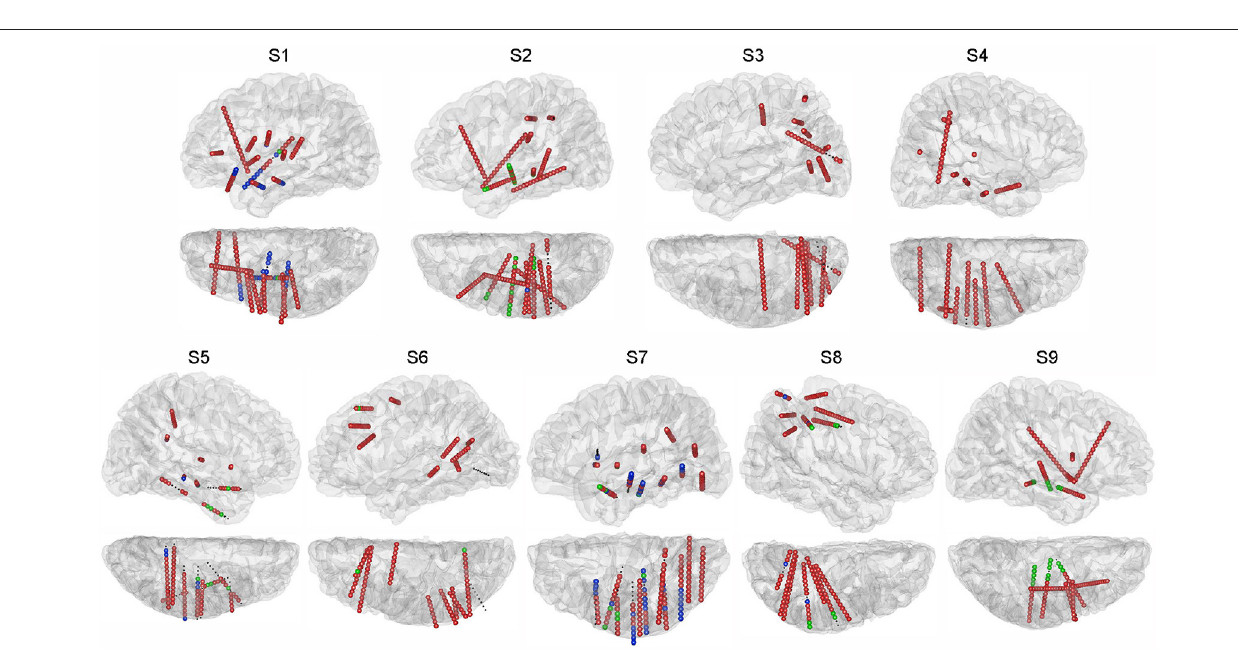
FIGURE 2 | Electrode locations projected on the individual brain. For each subject, sagittal and transverse views of the hemisphere with electrodes are shown. Subjects S1, S3, S6, and S9 have electrodes in both hemispheres, and only the hemispheres containing the majority of electrodes are shown. Different colors of the SEEG contacts indicate the session in which the contact was utilized: green for the auditory session, blue for the visual session, red for both sessions. Small black dots indicate the SEEG contacts excluded from this